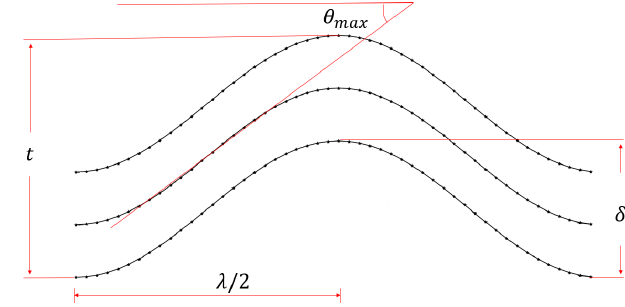
Figure 1. Geometric parameters regarded for severity determina- tion of a wrinkle defect (Mukhopadhyay et al.,